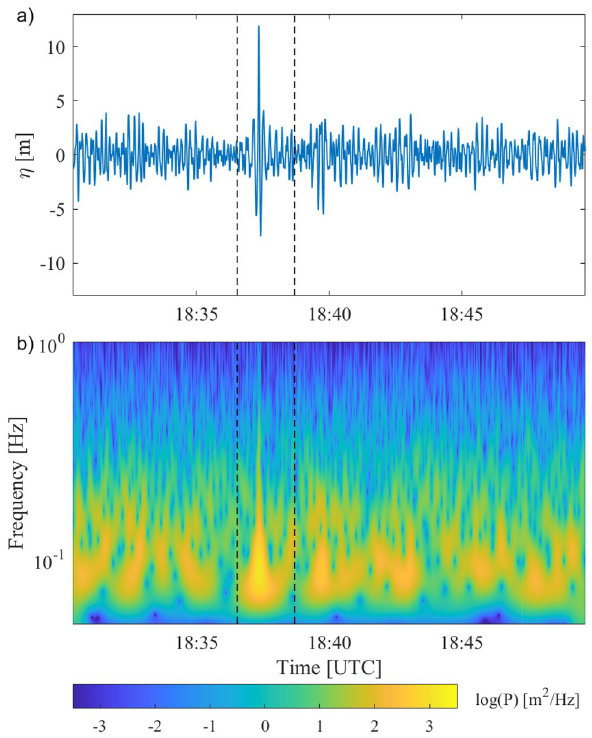
Figure 1. Rogue wave recorded on Nov 17, 2020. Vertical dashed lines indicate the wave group containing the rogue wave. ( a ) Surface elevation η . ( b ) Spectrogram of surface elevation using the Morlet